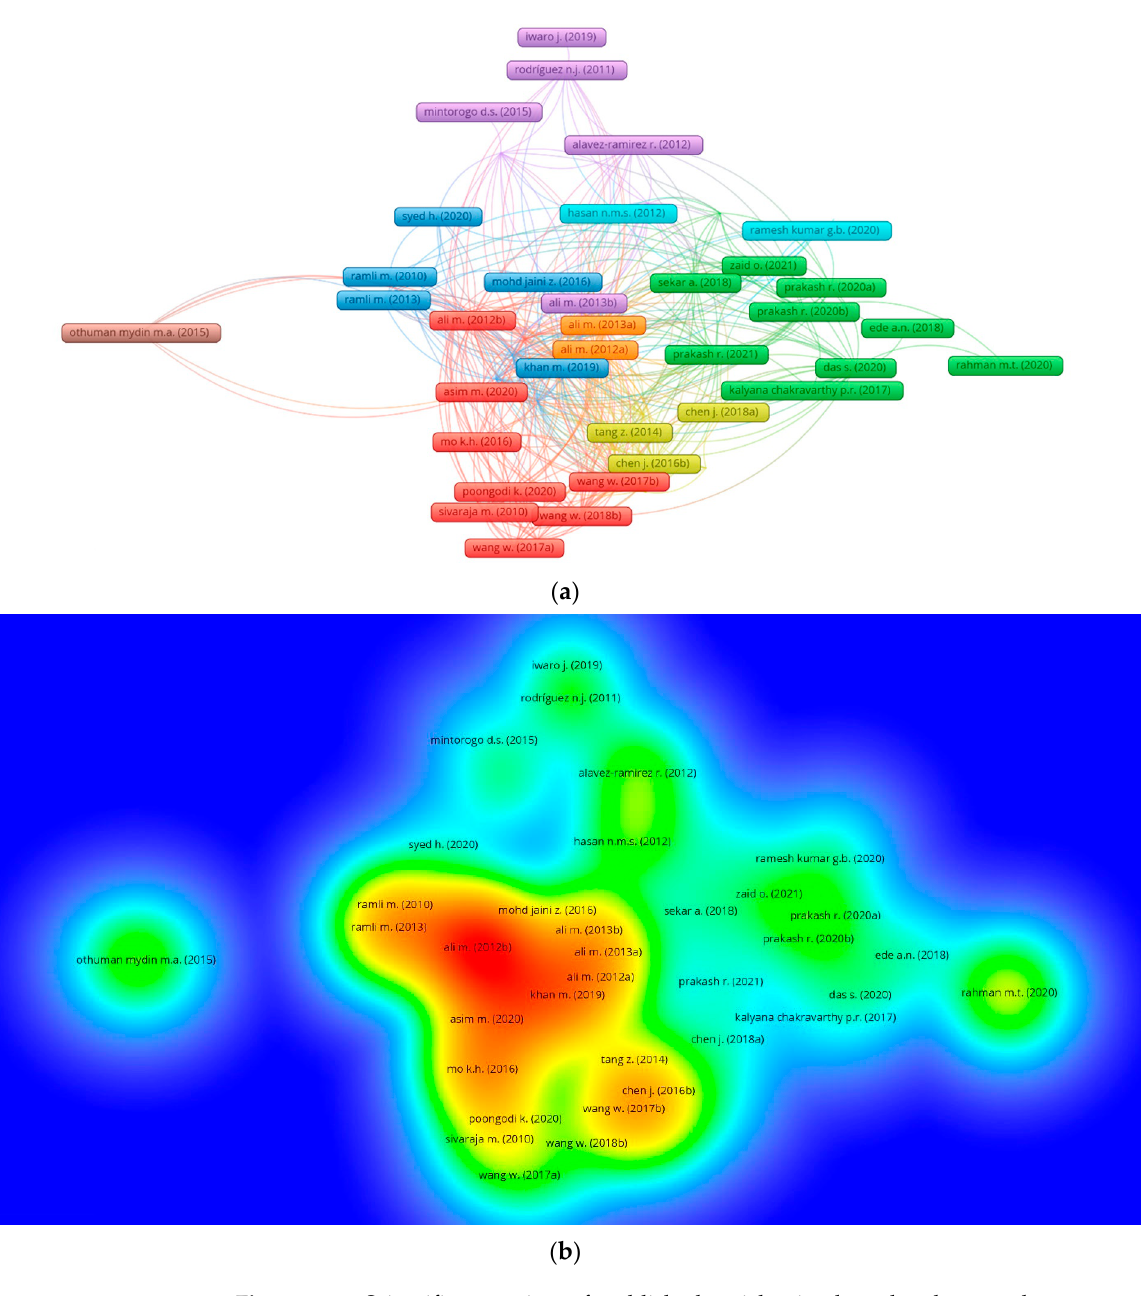
Figure 10. Scientific mapping of published articles in the related research area up to 2022: ( a ) Connected articles in terms of citations. ( b ) Density of connected articles. Table 4. Top 10 highly cited published articles up to 2022 in the research of coconut-fiber- reinforced